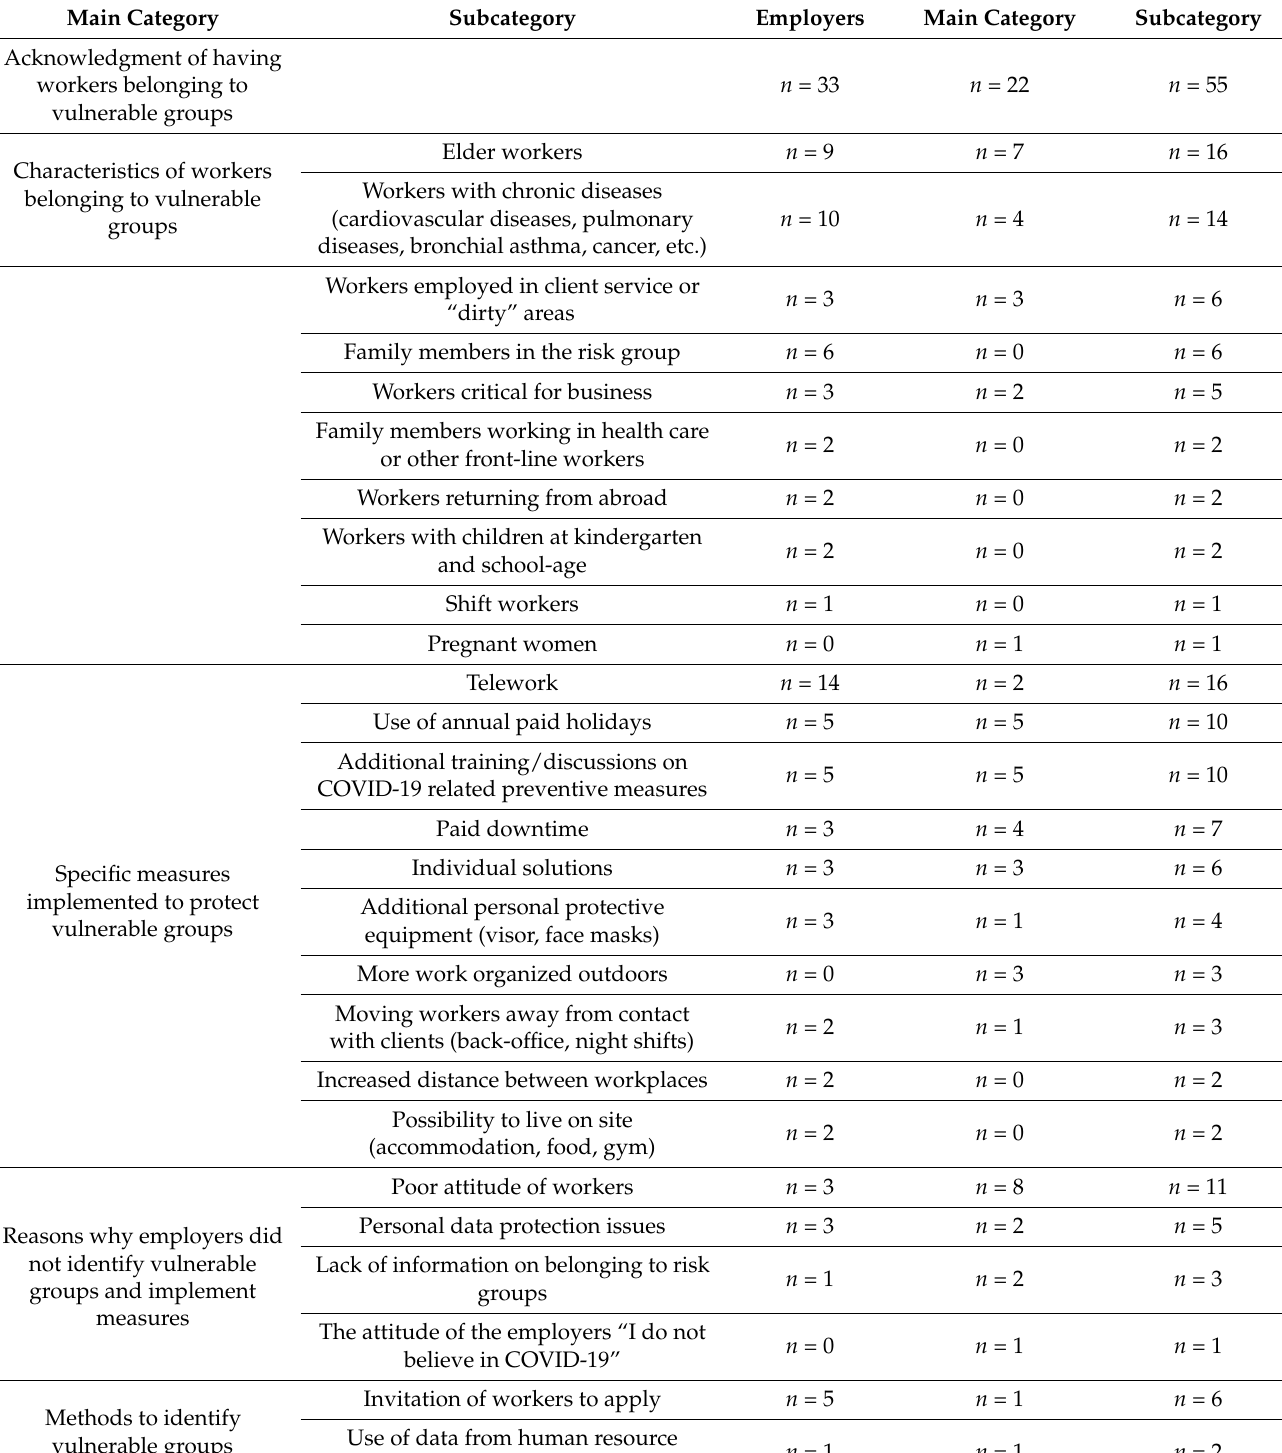
Table A5. Themes identified during research analysis ( n = number of persons for which theme was detected). Main